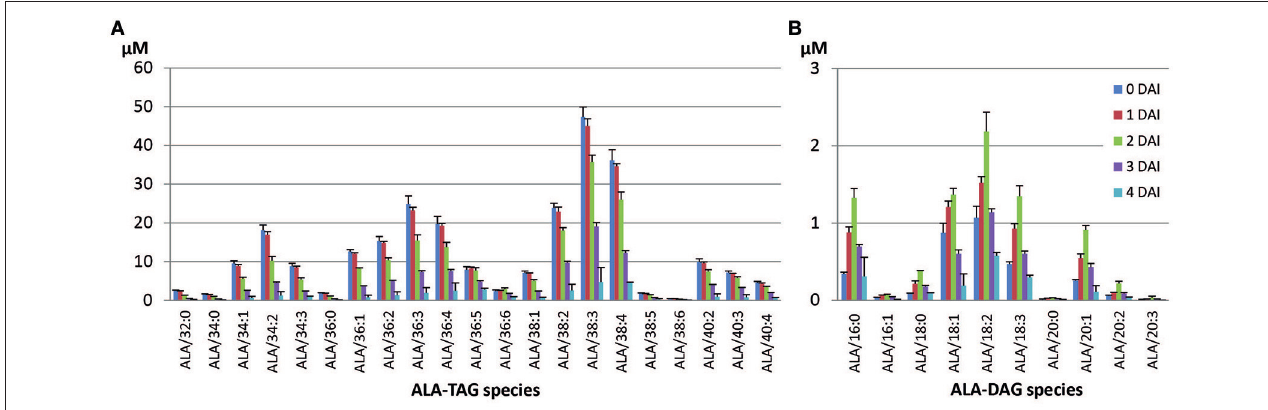
FIGURE 4 | Mobilization of ALA-containing TAG (A) and accumulated DAG (B) species during seedling development in Columbia. The two numbers in TAG species denote total number of carbons and total number of double bonds of two fatty acids in the TAG species.